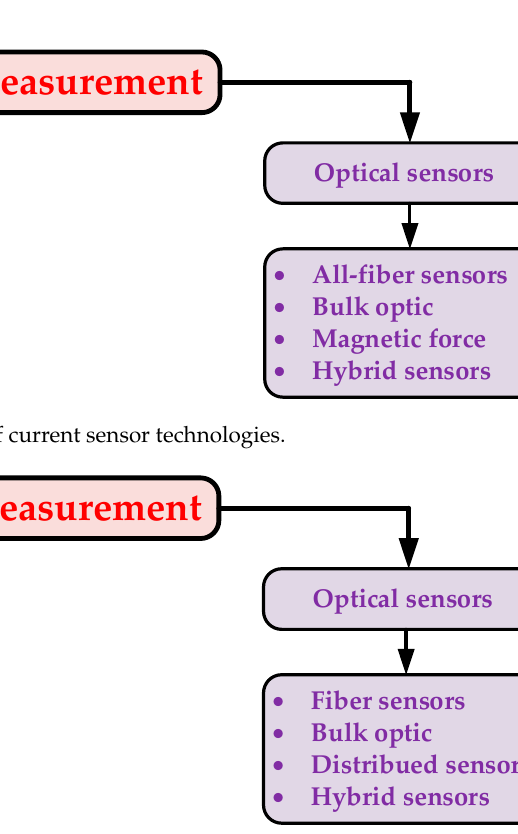
Figure 5. Classification of voltage sensor technologies.